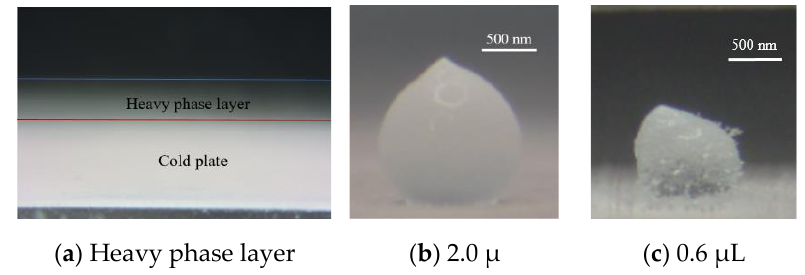
◦ C, T ◦ C, ϕ = 30%). w = − 130 a = 20